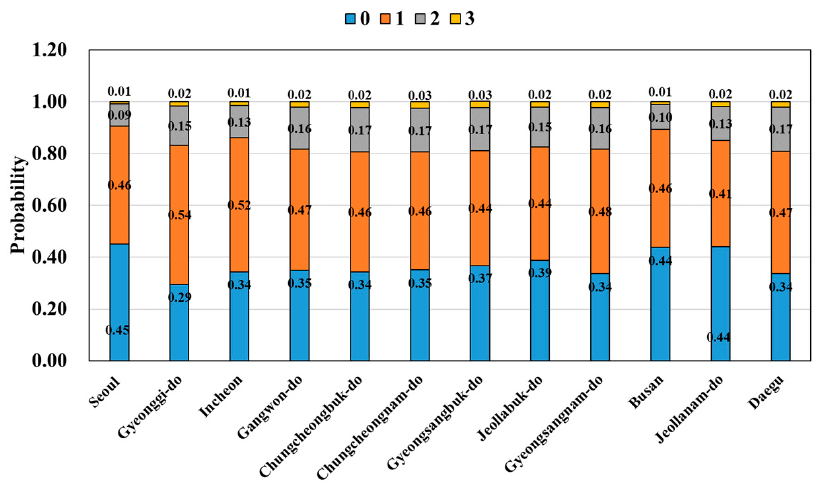
Figure 7. Probability of the number of registered vehicles per household by region.